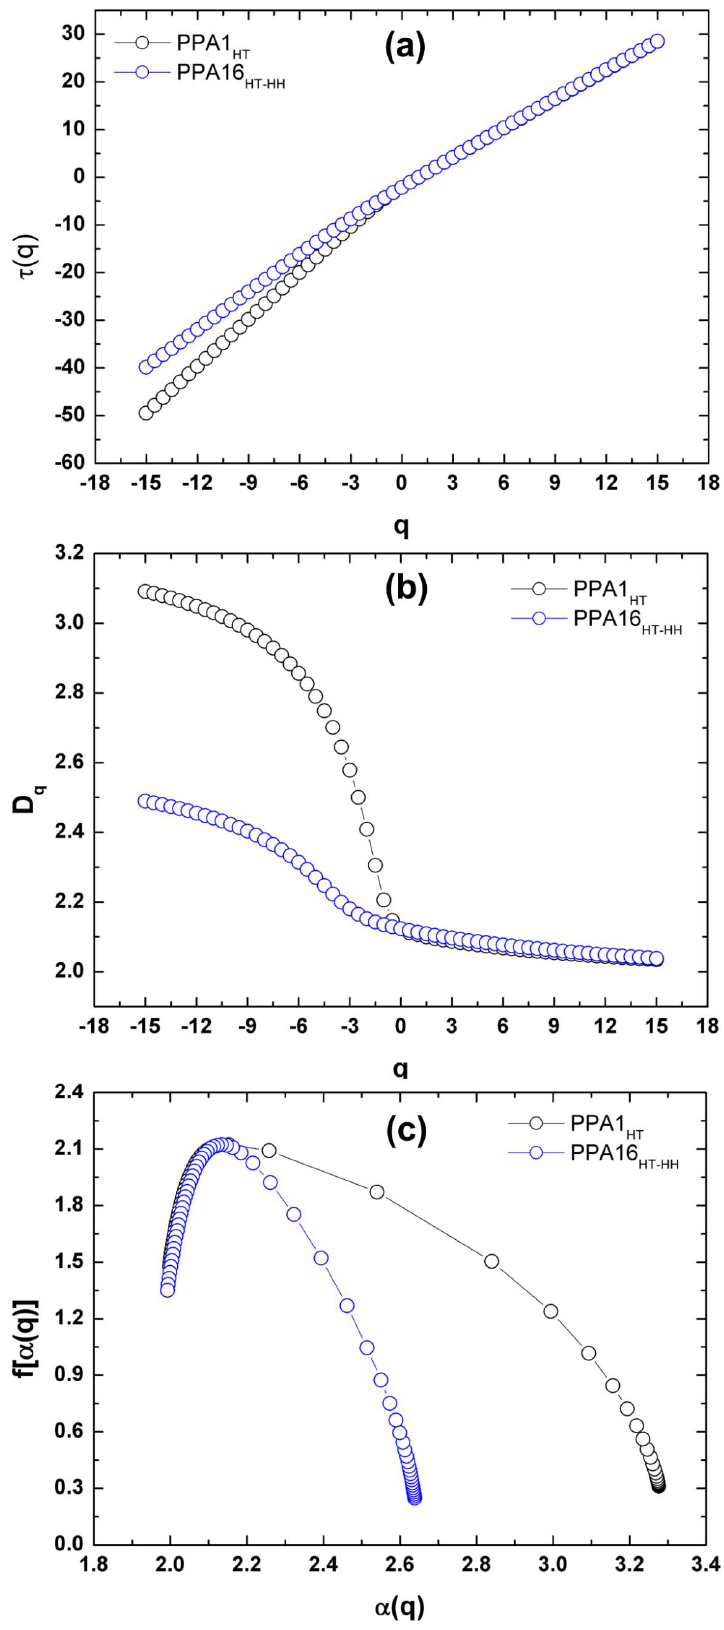
Figure 5. ( a ) Mass exponent τ ( q ), ( b ) generalized dimensions Dq, and ( c ) multifractal spectra ( f ( α ) versus α ) as a function of the order of moments for PPA1 HT and PPA16 HT-HH .